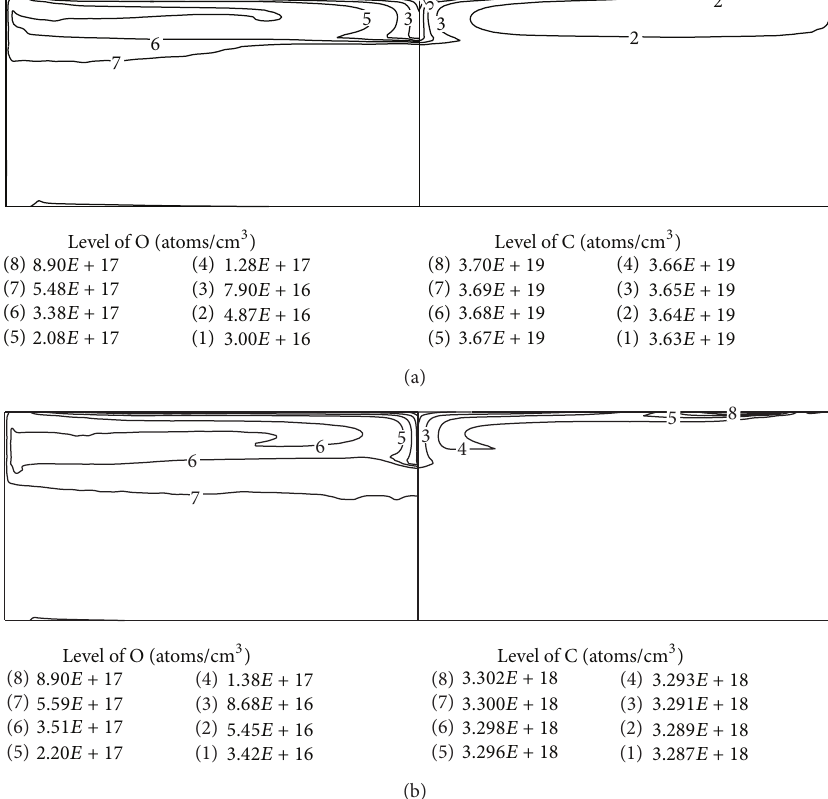
Figure 7: Distributions of O (left) and C (right) concentration in the silicon melt for different cover designs with surface reaction: (a) flat cover and (b) U